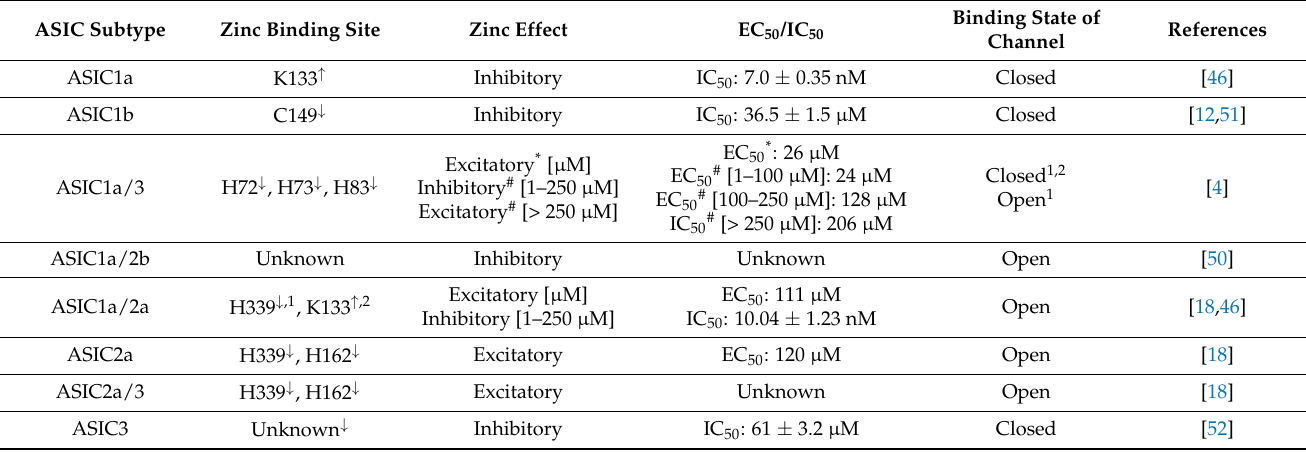
Table 1. Summary of zinc’s effects on different ASIC